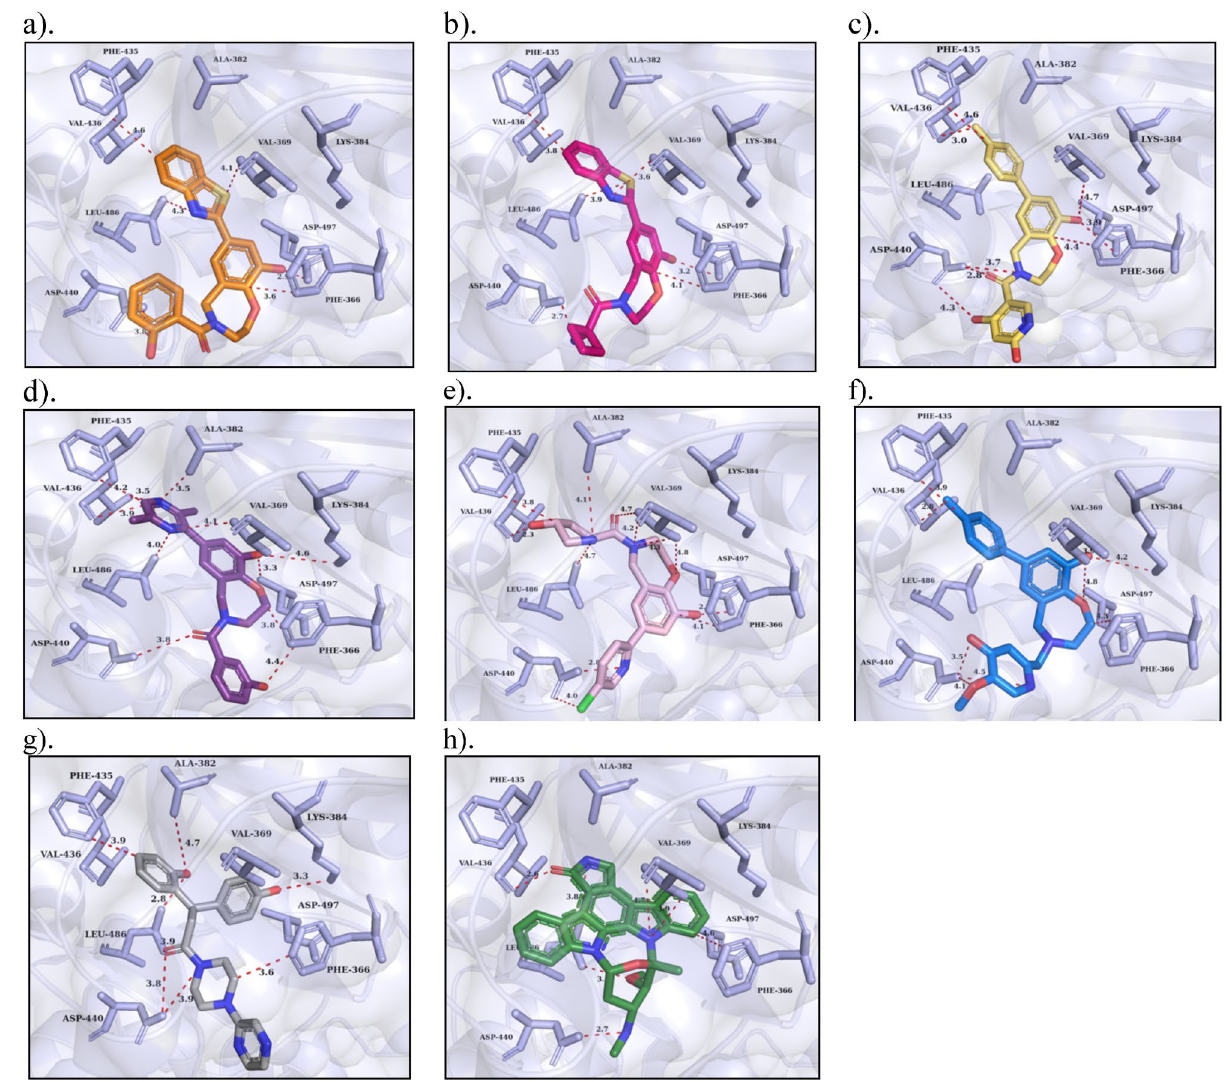
Figure 8. . Binding mode, interactions of (a) Compound-1, (b) Compound-2, (c) Compound-3 and (d) Compound-4, (e) Compound-5, (f) Compound-6, (g) Compound-7, and (h) Staurosporine (reference inhibitor) at the ATP binding pocket of PKC-η. The protein (light blue) is shown in the cartoon with the surface model, the active site residues are indicated in sticks with labeling and the binding interactions are indicated in red dotted lines with distances